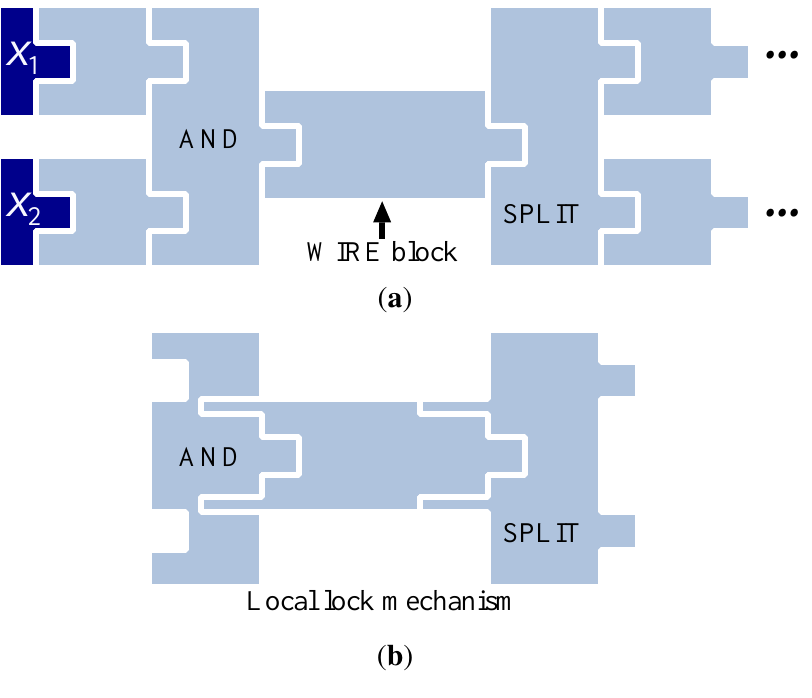
Figure 4. The gadgets for WIRE, AND, and